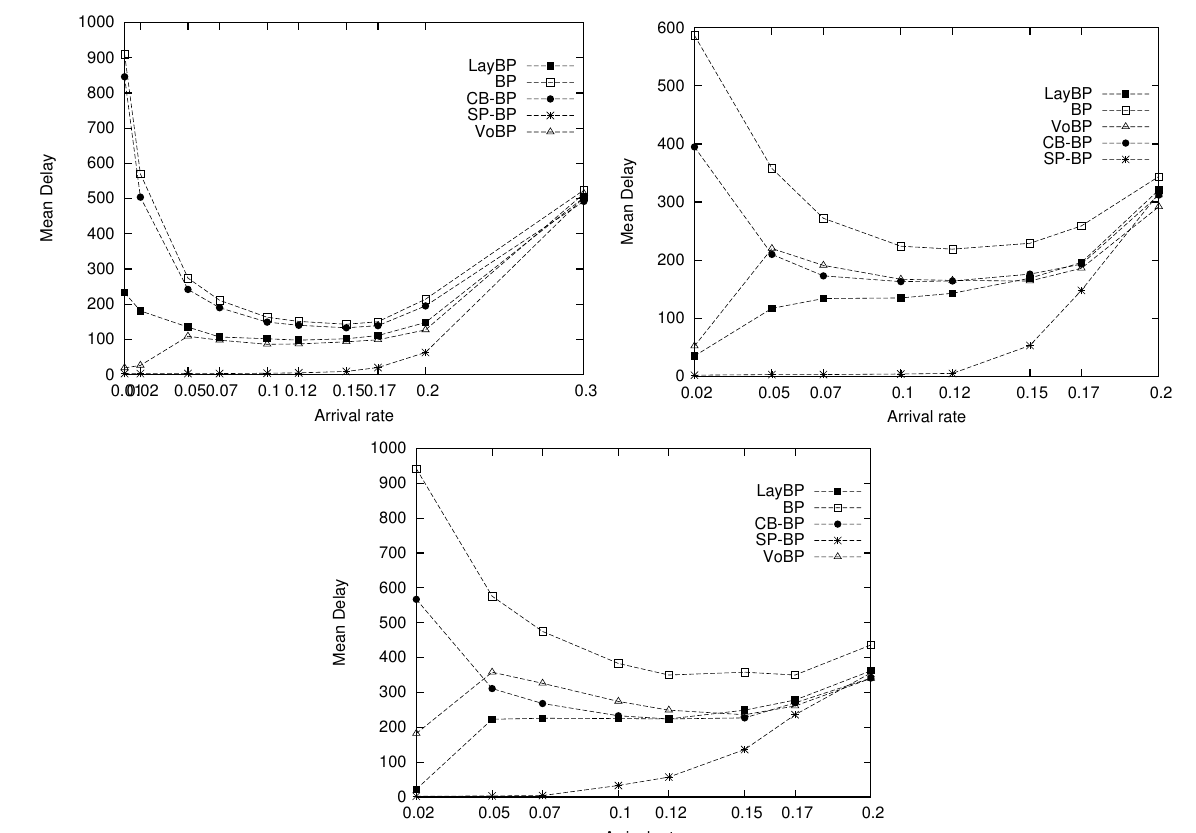
Figure 7. Delay performance for the three network topologies ( 16 , 22 and 30 nodes).